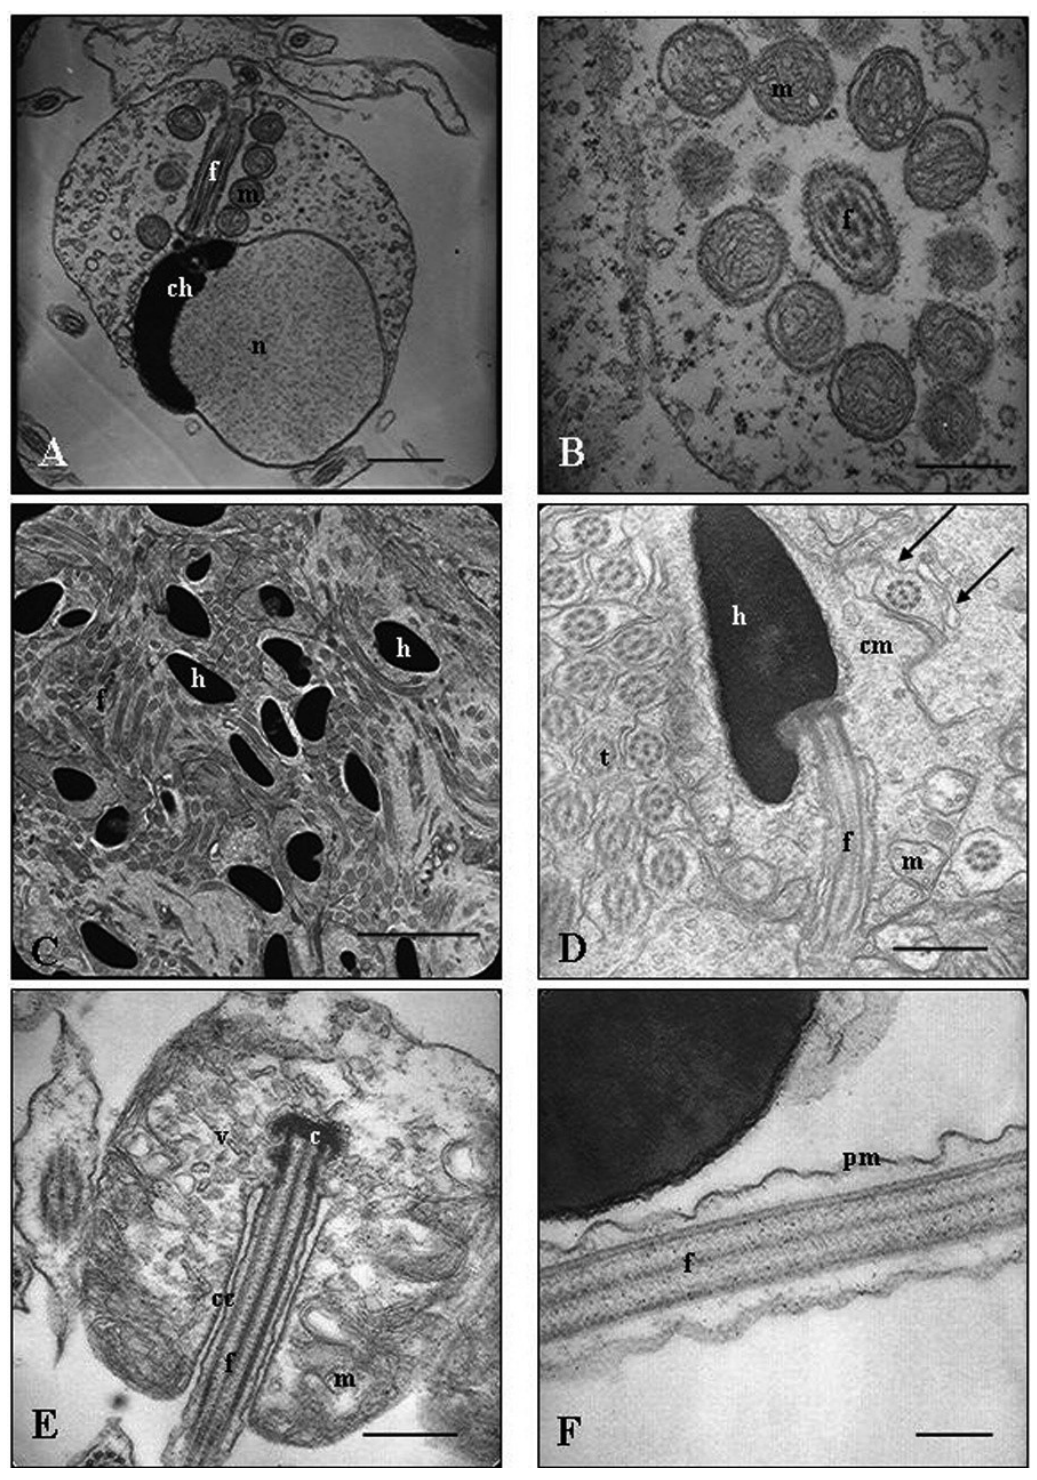
Fig . 2. – A, the flagellar axis is at an oblique angle to the spermatid nucleus (f, flagellar axis; ch, condensed chromatin; m, mitochondria; n, nucleus); B, spermatid midpiece, showing mitochondria with regularly organized cristae (f, flagellum; m, mitochondria); C, the spermatozoa inside testicular lobules do not exhibit cytoplasmic masses around their heads (f, flagella; h, heads); D, H. dactylopterus spermatozoa are of the complex type of anacrosomal introsperm, typical of internal fertilizing species (cm, cytoplasmic mass; h, spermatozoa’s head; f, flagellum; m, mitochondria; t, sperm tails). The arrows show the lateral projections of the flagellum; E, spermatozoon midpiece, in which we can clearly see a cytoplasmic channel (c, centriole; cc, cytoplasm channel; f, flagellum; m, mitochondria; v, vesicles); F, undulating surface of spermatozoon flagellum (f, flagellum; pm, plasma membrane). Scale bars: A, 1 μm; B, 0.25 μm; C, 2.5 μm; D, 2 μm; E-F, 0.5